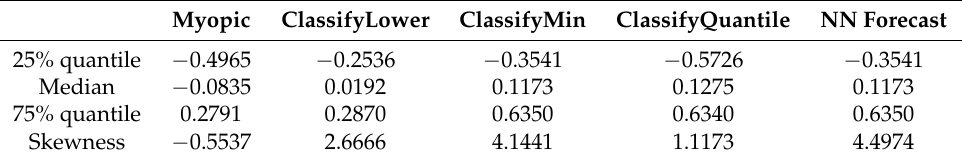
Table 2. Aggregated